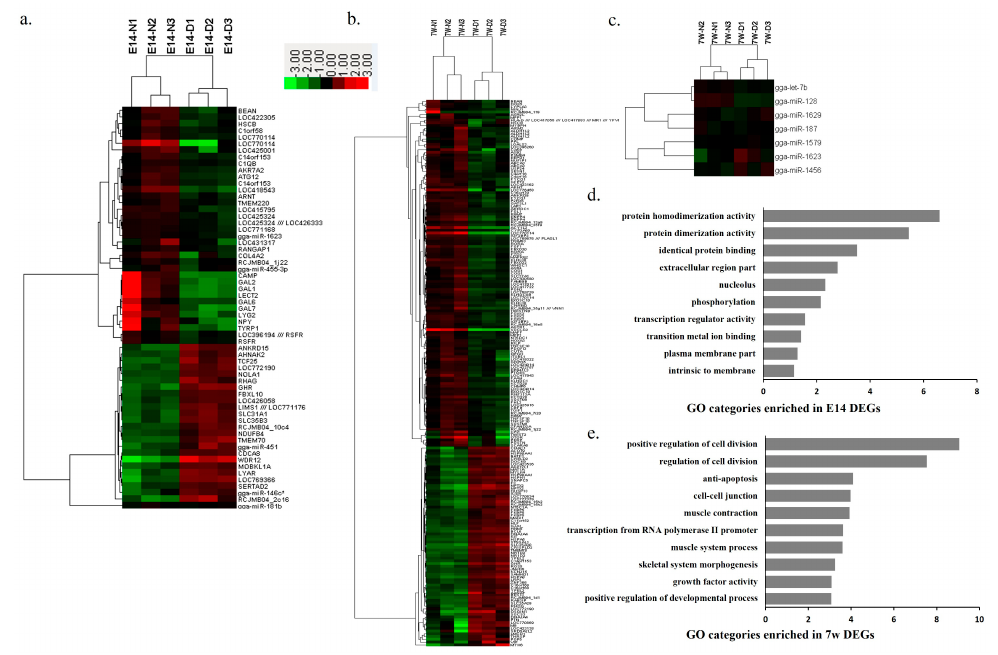
Figure 2. Differentially expressed genes and miRNAs between SLD and normal chickens. ( a ) Hierarchical clustering of 55 DEGs and five DEMs between normal and SLD chickens at E14; ( b ) Hierarchical clustering of 173 DEGs between normal and SLD chickens at 7w; ( c ) Hierarchical clustering of seven DEMs between normal and SLD chickens at 7w; ( d ) GO enrichment for the E14 DEGs. The y axis represents GO terms and the x axis represents fold enrichment (with p value < 0.05); ( e ) GO enrichment for the 7w DEGs. The y axis represents GO terms and the x axis represents fold enrichment (with p value < 0.05).